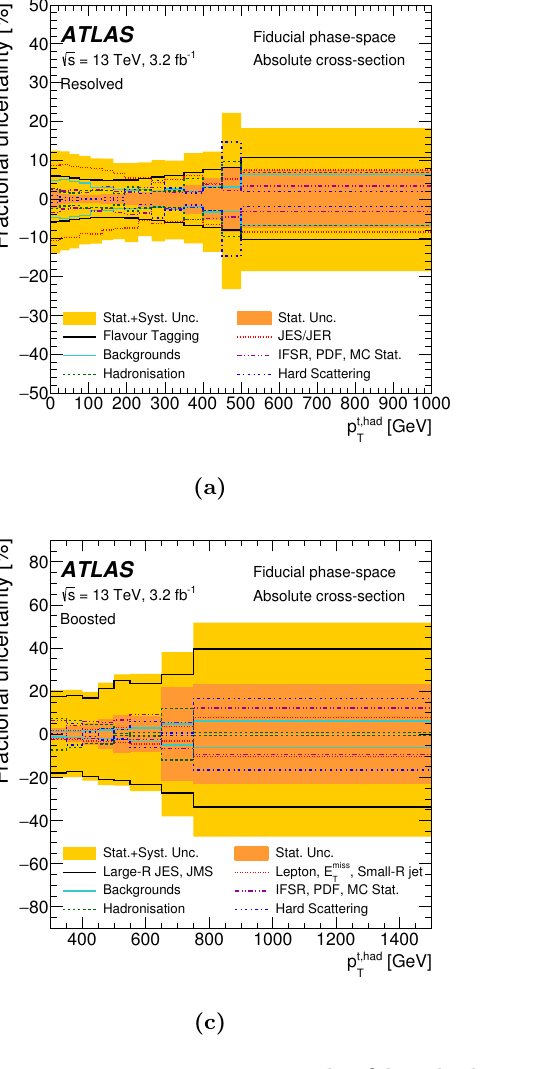
(cid:12) (cid:12) (cid:12) y t; had (cid:12) ) of